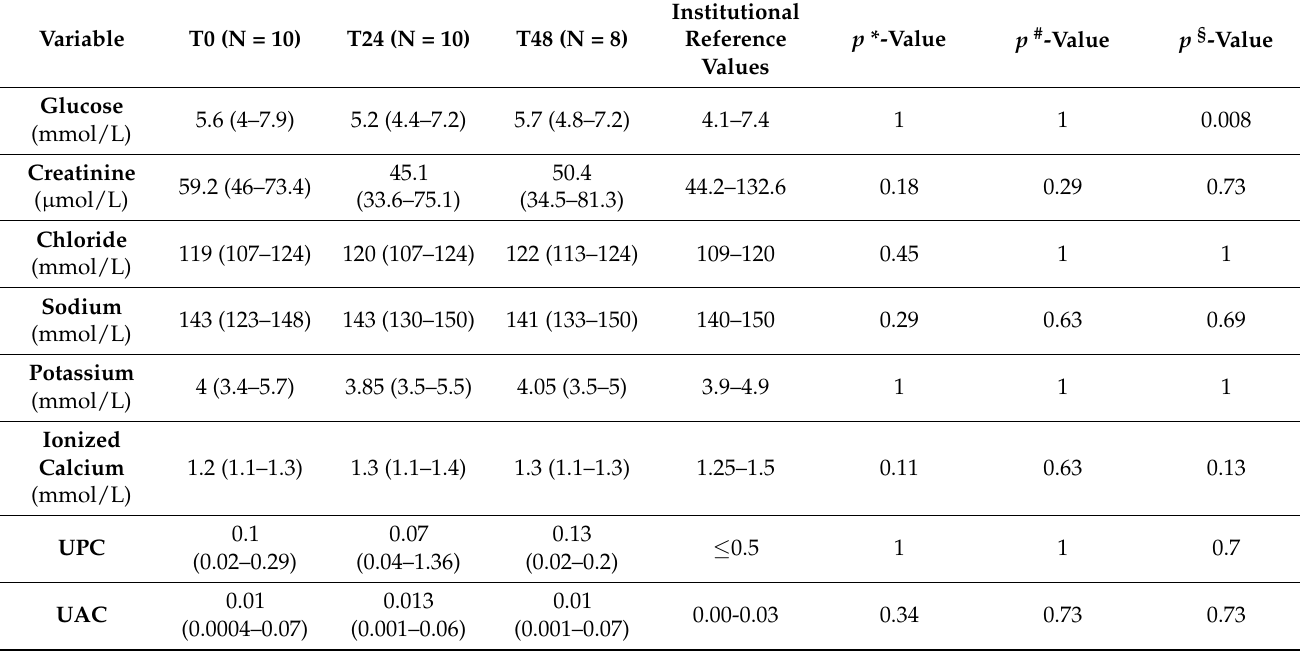
Table 1. Descriptive statistics reported as the median and range (minimum–maximum value) and comparison for clinico- pathological variables among samples collected at T0 (pre-HES infusion), at T24 (after 24 h of HES continuous rate infusion), and at T48 (after 48 h from baseline and after HES CRI